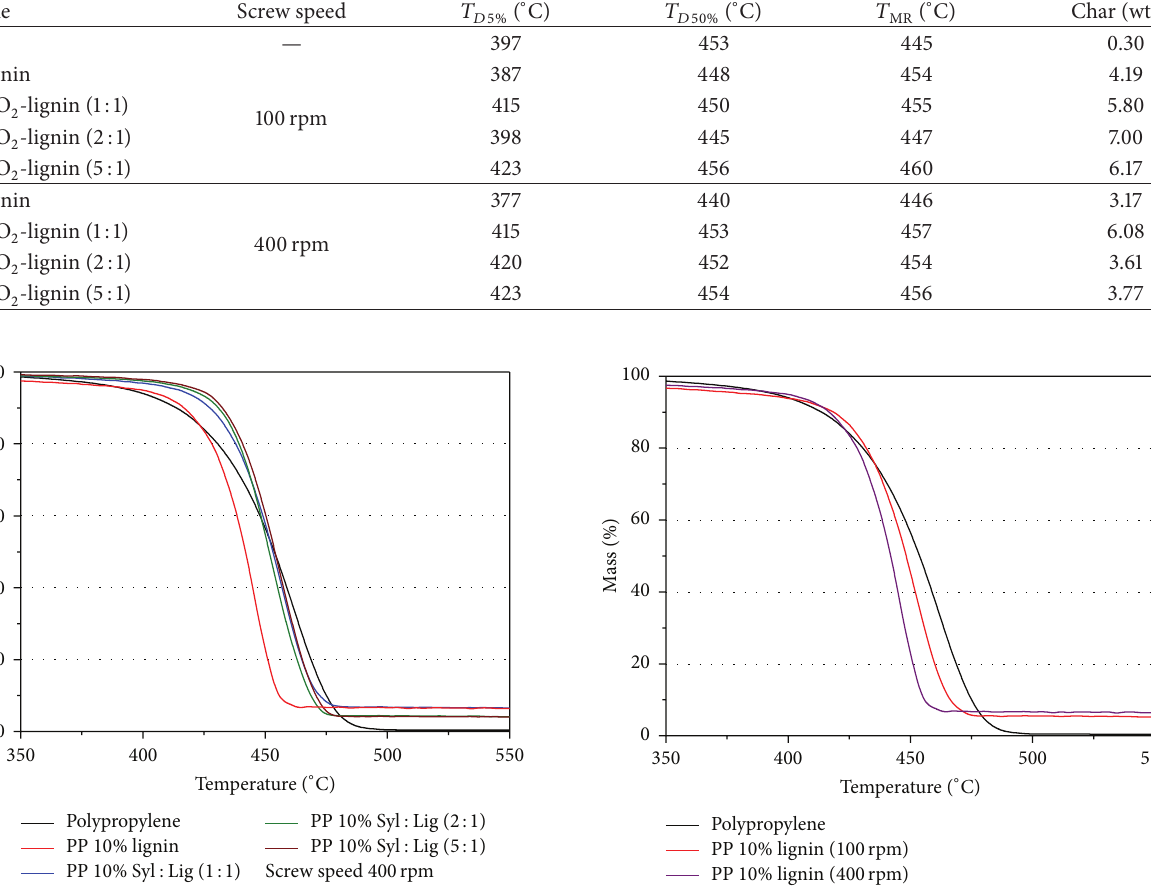
Table 4: Comparison of the thermal decomposition temperatures of PP/silica-lignin composites under different extrusion conditions char wt.% formed during the test.